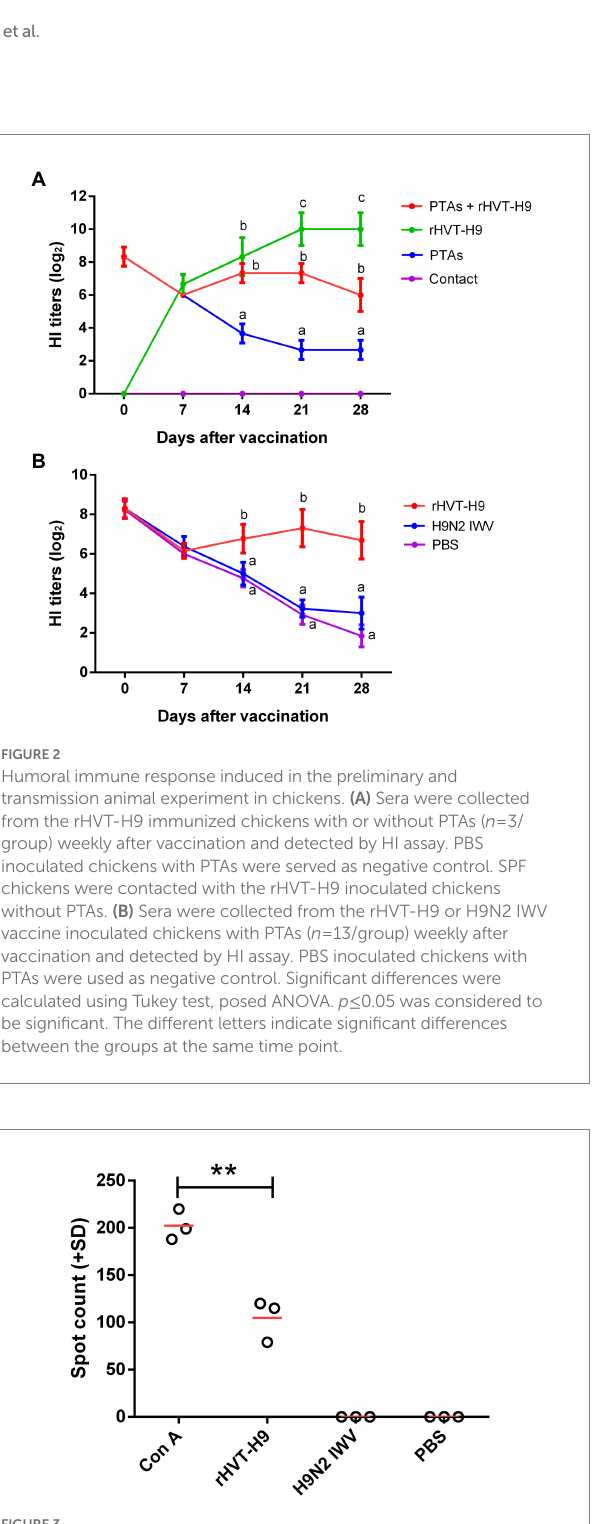
FIGURE 3 ELISpot assay to measure ch-IFN- γ production by splenocytes of vaccinated chickens with PTAs. Splenocytes of chickens with PTAs ( n = 3/group) were harvest twenty-eight-days after vaccination. The inactivated H514 (50 μ l/well) were used to restimulate splenocytes. Con A (10 μ g/ml) stimulated splenocytes served as positive control. Student’s t -test was used to compare the differences in means between groups. Symbol (*) denotes differences between two groups (* p < 0.05, ** p < 0.01, *** p <